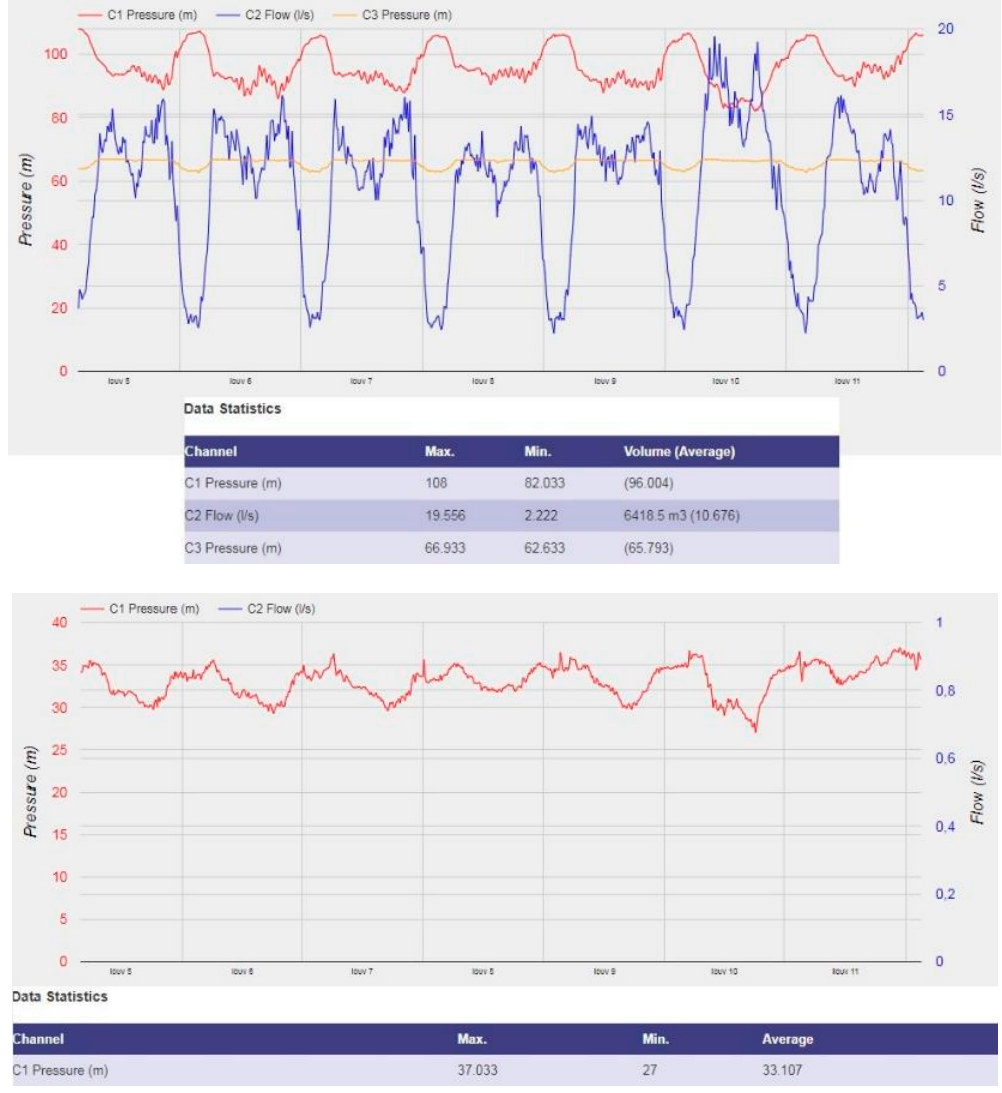
Figure 6. Weekly set of data from the 5th to the 12th of June